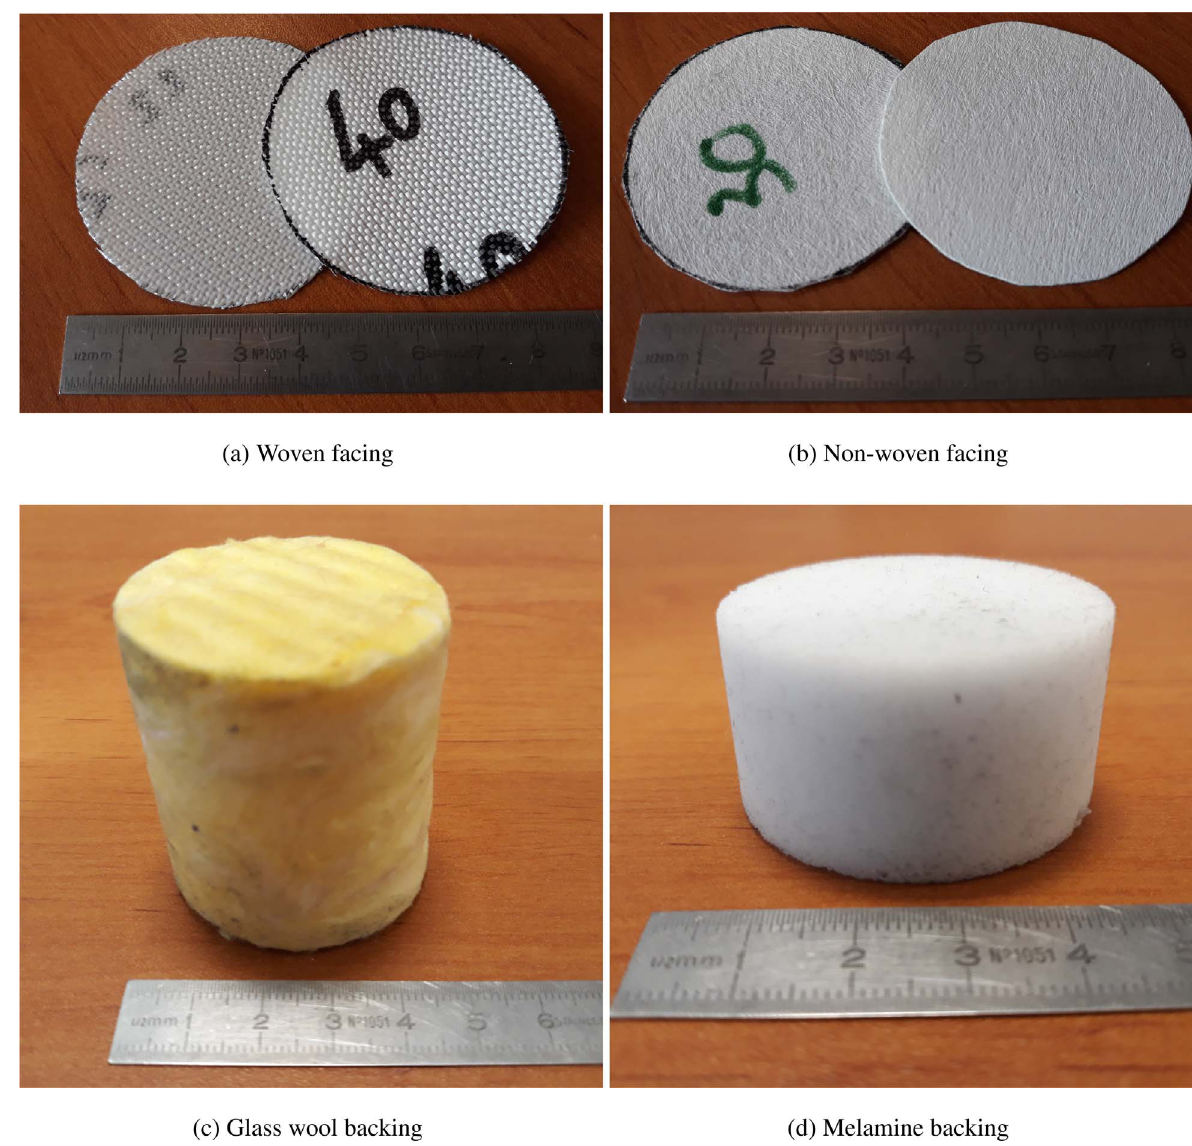
Figure 7. Photographs of samples of backing and facing media under